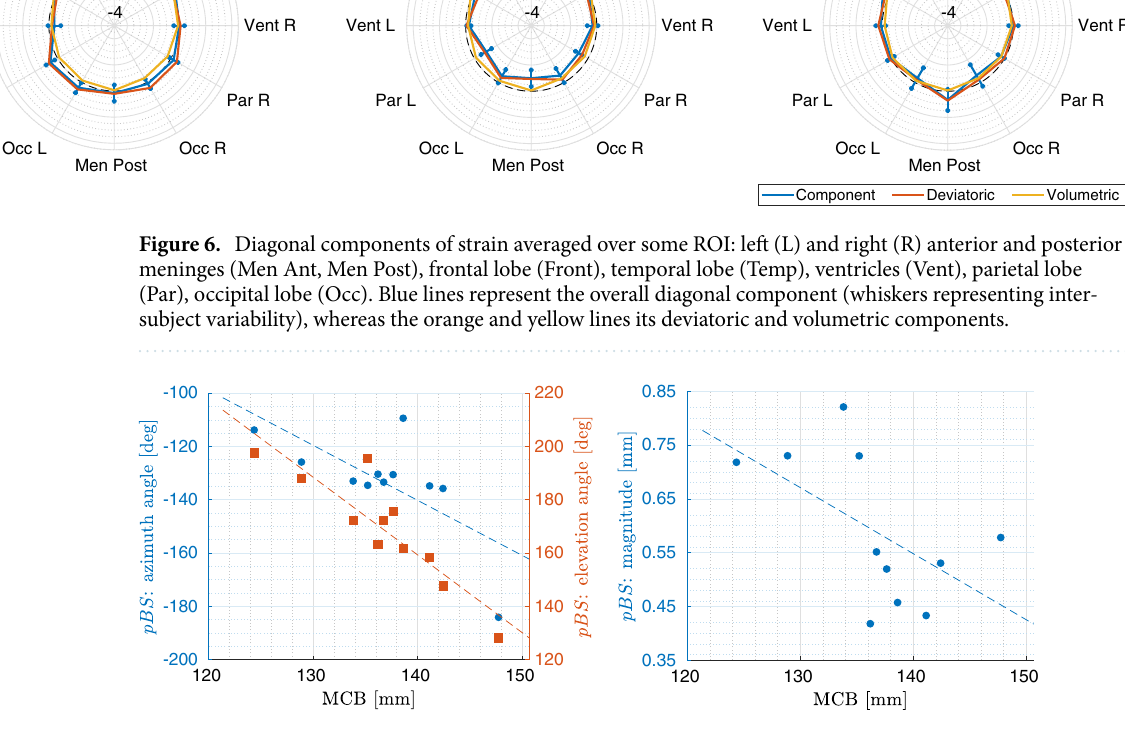
Figure 7. Scatter plots of the correlation between PBS and MCB. Azimuth (blue dots) and elevation (orange squares) angles are reported on the left against values of MCB, whereas against magnitude of PBS on the right. As reference, linear fit is superimposed to the data.